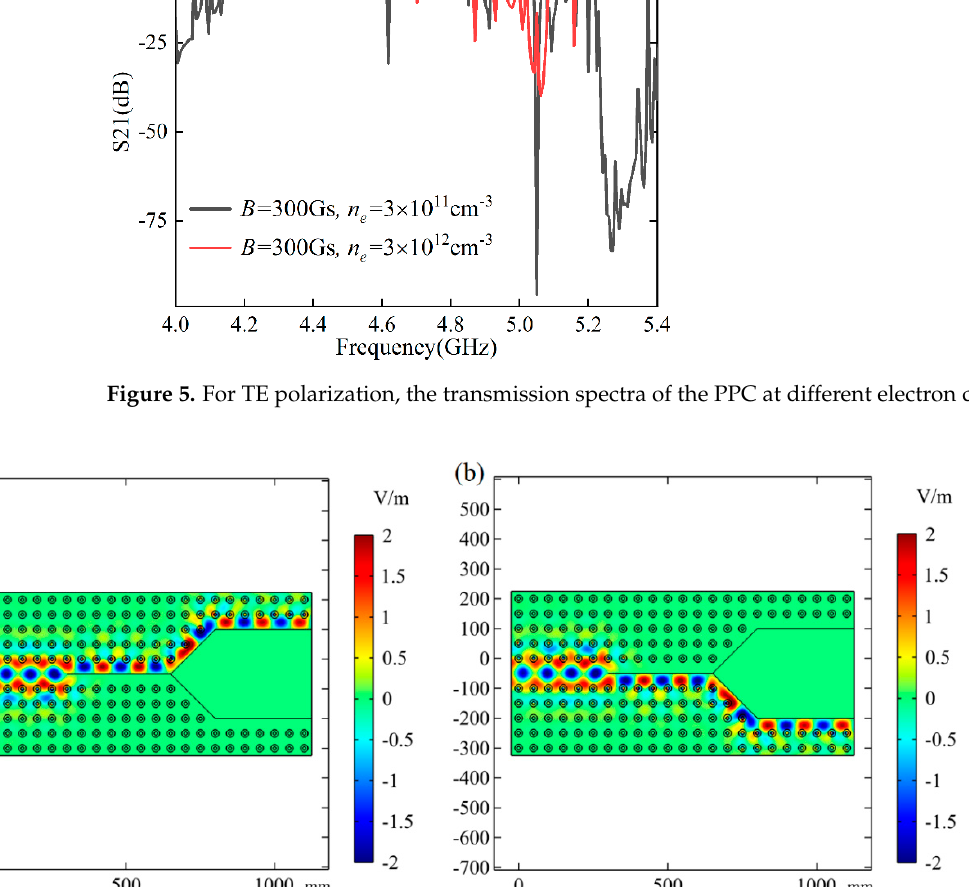
Figure 6. The electric field distribution for the Y-shaped waveguide when the magnetic field is along the ( a ) +z direction; ( b ) -z direction. the ( a ) +z direction; ( b ) − z